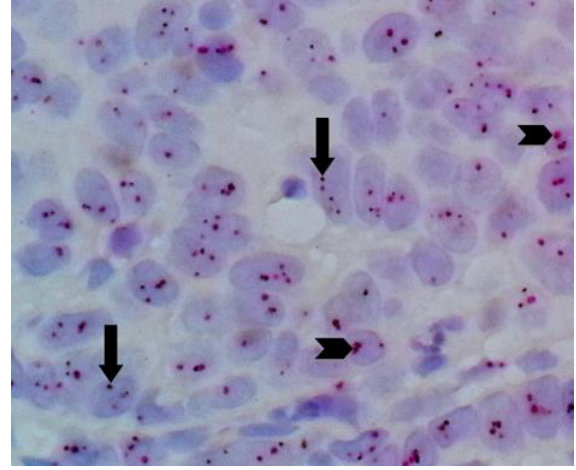
Fig. 9. Invasive Ductal Carcinoma With Amplified HER2 Gene by Silver DNA in Situ Hybridization (same case in Figure 8 with higher magnification): each carcinoma cell nucleus shows an average of 3 to 4 HER2 gene black SISH signals (arrows) and 1to 2 chromosome 17 red ISH signals (arrow heads) with a ratio of > 2 (100X)